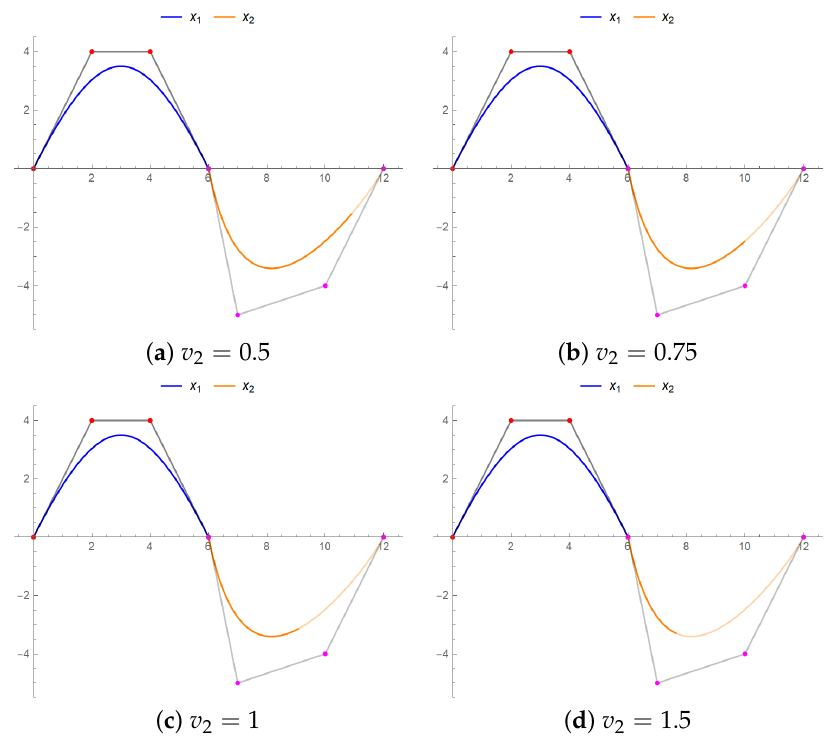
Figure 8. C 0 continuity of two cubic fractional Bézier curves.